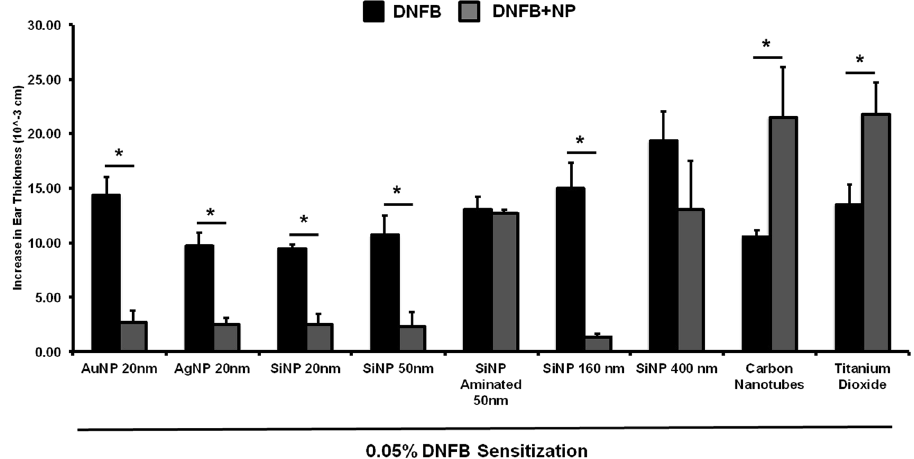
Figure 6. Co-challenge experiments with different NP types in mice sensitized to DNFB. Mice were sensitized to 0.05% DNFB alone. In the challenge phase, the right ear was exposed to 0.2% DNFB and the left ear was co-challenged 0.2% DNFB + NP combination. AuNP (20 nm), Silica NP (20 nm, 50 nm, 160 nm) and AgNP (20 nm) reduced the ear swelling response. Aminated Silica NP (positive charge) had no effect. Carbon nanotubes (CNT) and Titanium dioxide (TiO 2 ) increased the ear swelling response significantly over the control. Silica NP (400 nm) trended to reduce the swelling response but it was not significant compared to the control ear. Mean ± SEM, * p < 0.05, 2 Student’s tailed t-Test, paired with unequal variances, N = 3–4.